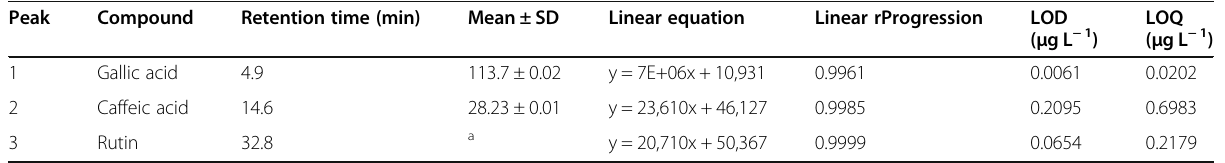
Table 1 Hydroethanolic extract of S. adstringens analyzed by HPLC. Retention time in minutes and the amounts of phenolic compounds in μ